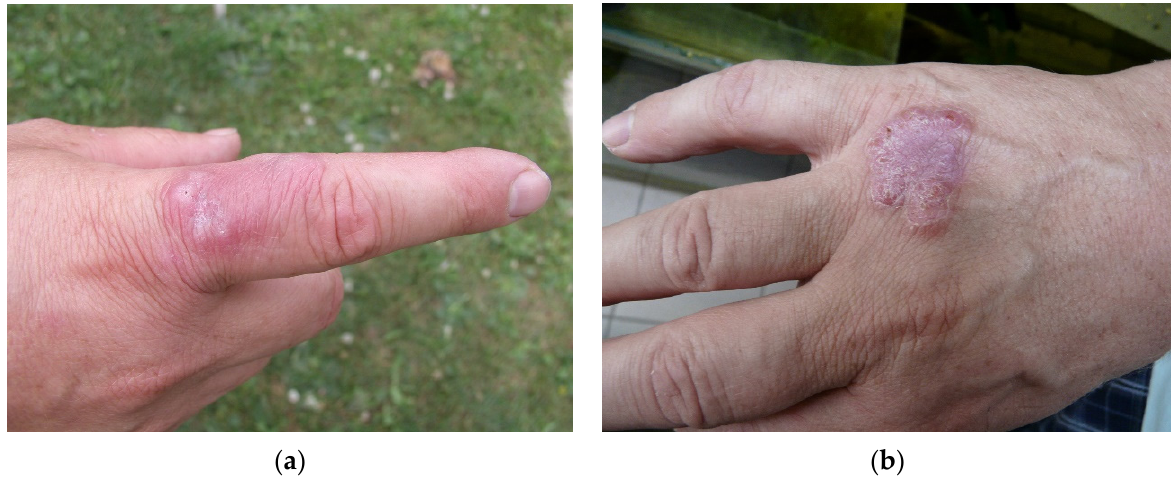
Figure 1. Fish tank granuloma diagnosed in professional aquarist on two places on his right hand: ( a ) infection on 17 June 2003; ( b ) infection on 2 July 2008 (photo I. Pavlik).